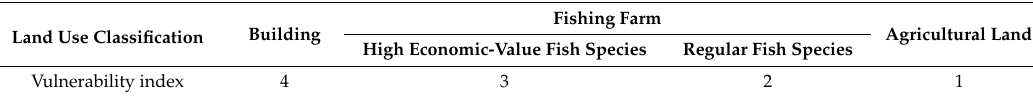
Table 3. Vulnerability index for different land